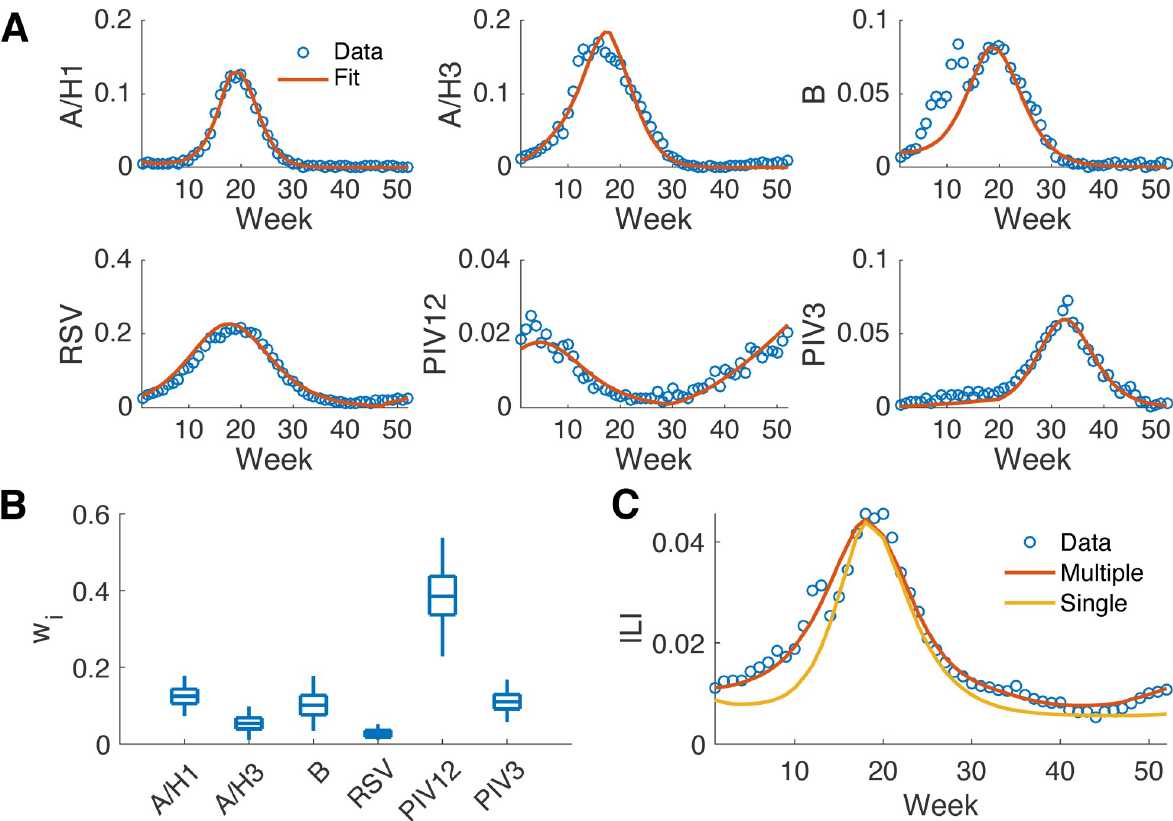
Fig 2. Disaggregation of national ILI during the 2010–2011 season to multiple viral components. Model fitting to the positivity rates of six respiratory pathogens (A). Time starts from the 40 th week in 2010. The distribution of the multiplicative factor, w MCMC (B). The boxes and whiskers show the interquartile and 95% credible intervals. Fitting ILI as an amalgamation of six pathogens versus as a single agent (C).